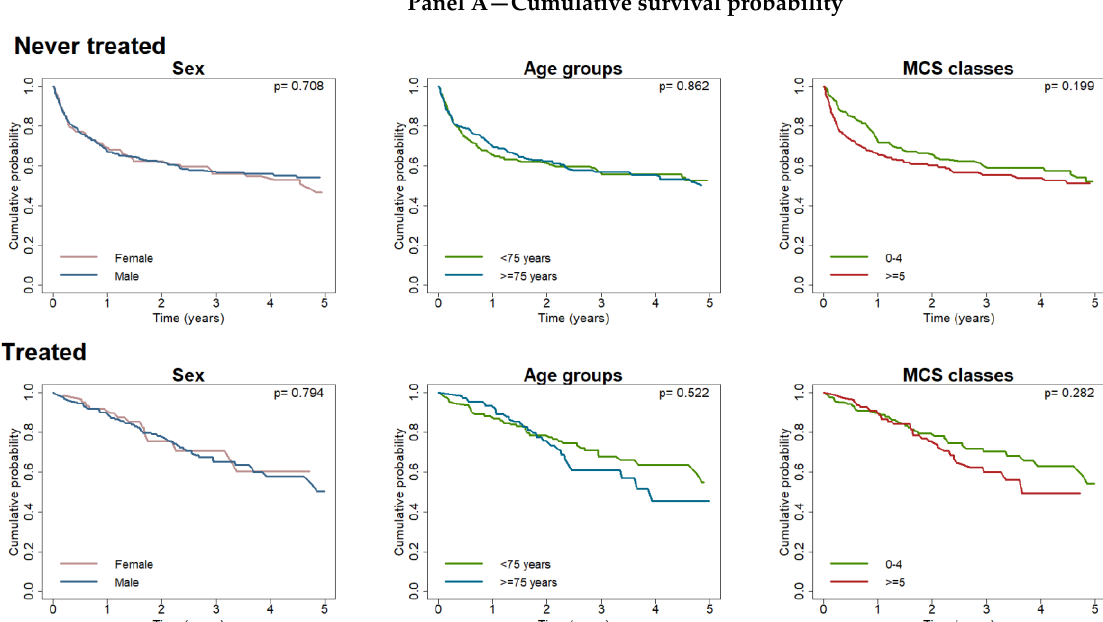
Figure 2. Cumulative survival probability ( Panel A ) and probability of not developing Acute Exacerbations ( Panel B ) by sex, age groups and Multisource Comorbidity Score (MCS) classes in not treated and treated patients (Treated: patients with at least one prescription of antifibrotics during the follow-up were considered as treated). The cumulative acute exacerbation-free probability is calculated considering death as competing risk event.